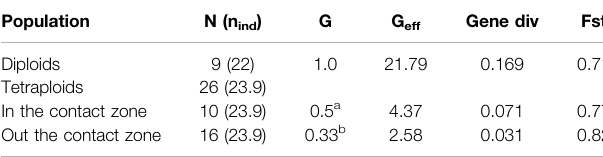
TABLE 2 | Genetic variation divided into cytotypes and contact